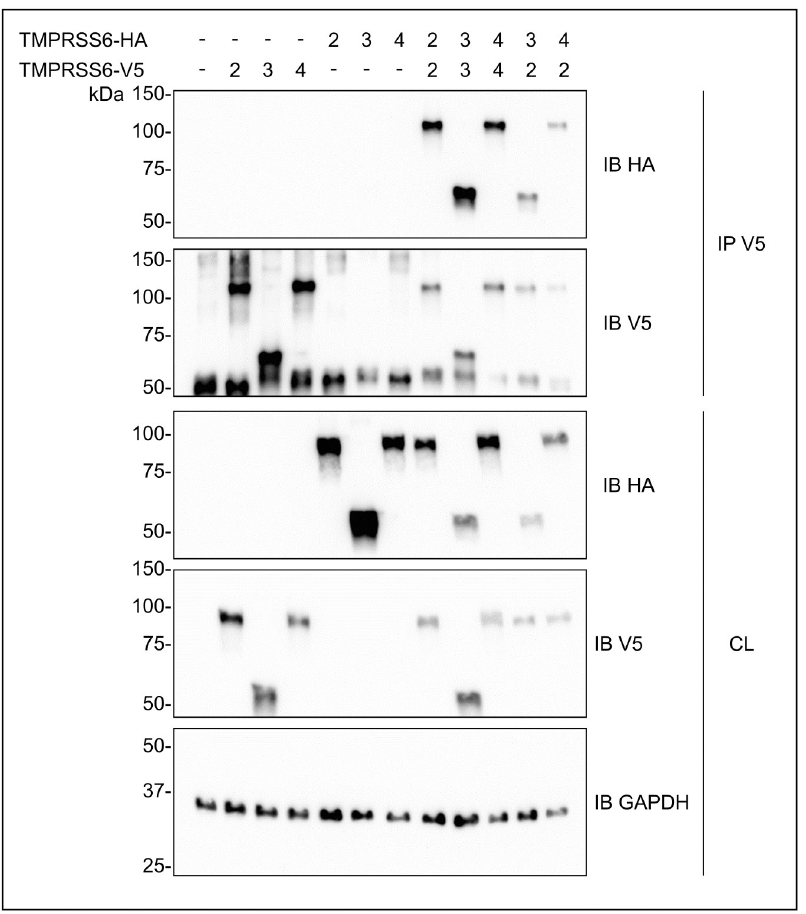
Fig 2. TMPRSS6 isoforms engage in homo- and hetero-interactions. HEK293 cells were co-transfected with V5- and HA-tagged TMPRSS6 isoforms. Homo- and hetero-interaction of TMPRSS6 isoforms were assessed by immunoprecipitation (IP) of cell lysate (CL) using an anti-V5 antibody. Isoform immunoprecipitation was detected using anti-V5 and anti-HA antibodies. Equal amount of CL was loaded on SDS-polyacrylamide gels and cell GAPDH was used as a loading control (n =